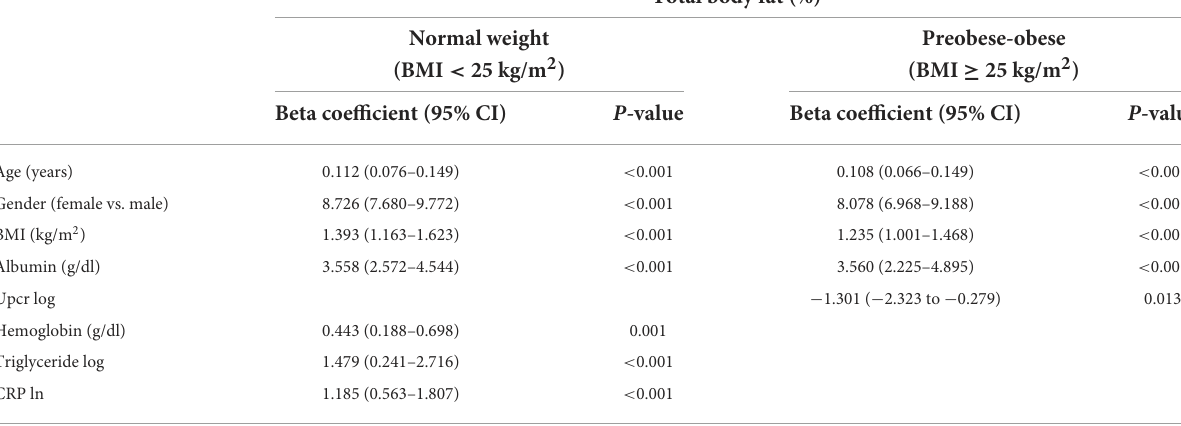
(Supplementary Table 1) and multivariate linear regression for TBF% (Supplementary Table 2) revealed a significant relationship between TBF% and age, gender, Upcr log, BMI, waist, hemoglobin, triglyceride log, albumin, and CRP ln. We further analyzed the association between TBF% and variants according to BMI subgroups (BMI < 25 kg/m 2 and BMI ≥ 25 kg/m 2 ) (Table 3). Our results showed that TBF% is significantly associated with age, gender, BMI, albumin, hemoglobin, triglyceride log, and CRP ln in normal weight (BMI <